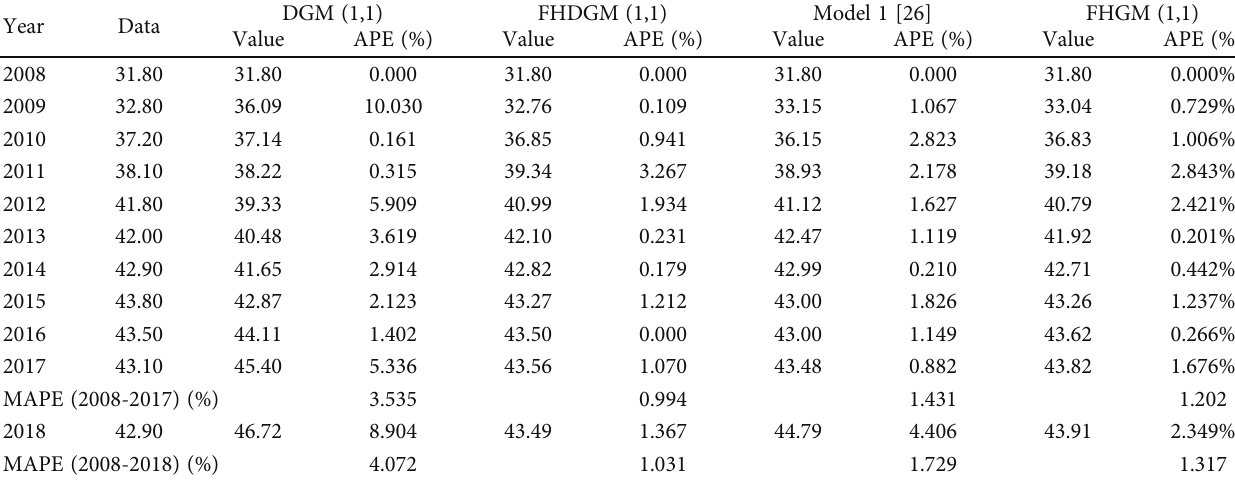
Table 4: Fitted and predicted values in natural gas consumption of